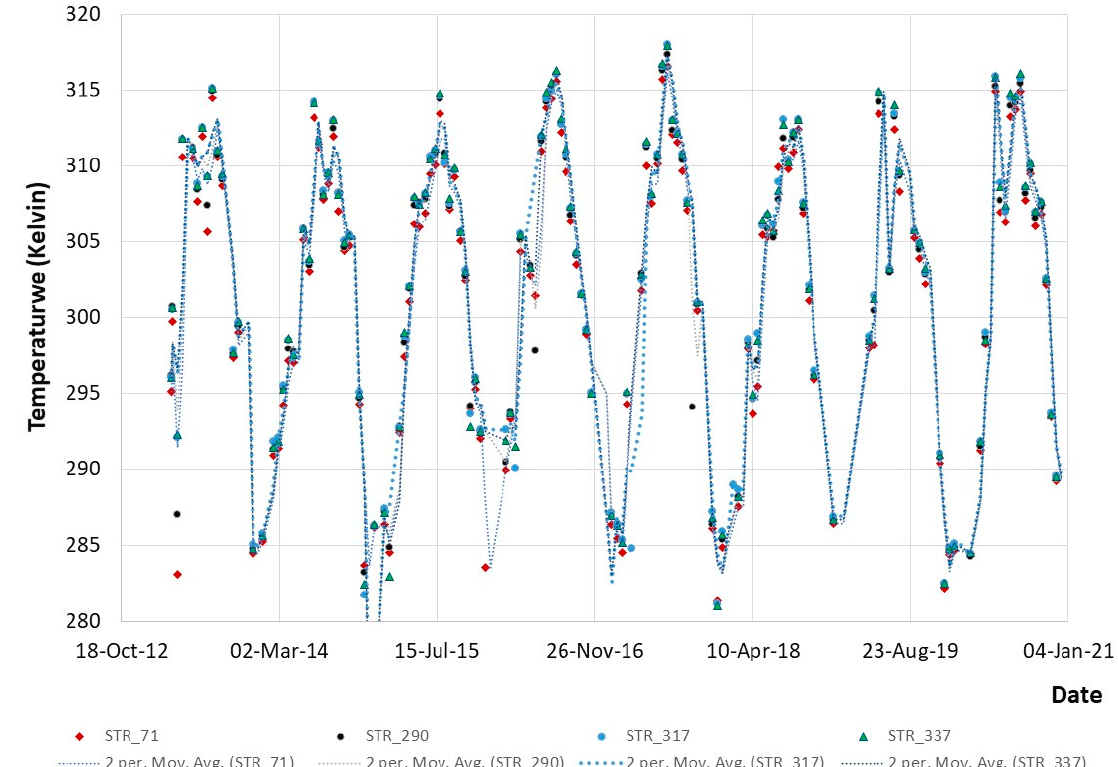
Figure 13. Temperature profile (in Kelvin) for four historic buildings: STR_71; STR_290; STR_317; and STR_337 (see Figure 12), as reported from the Google Earth Engine for the period 2013–2020.